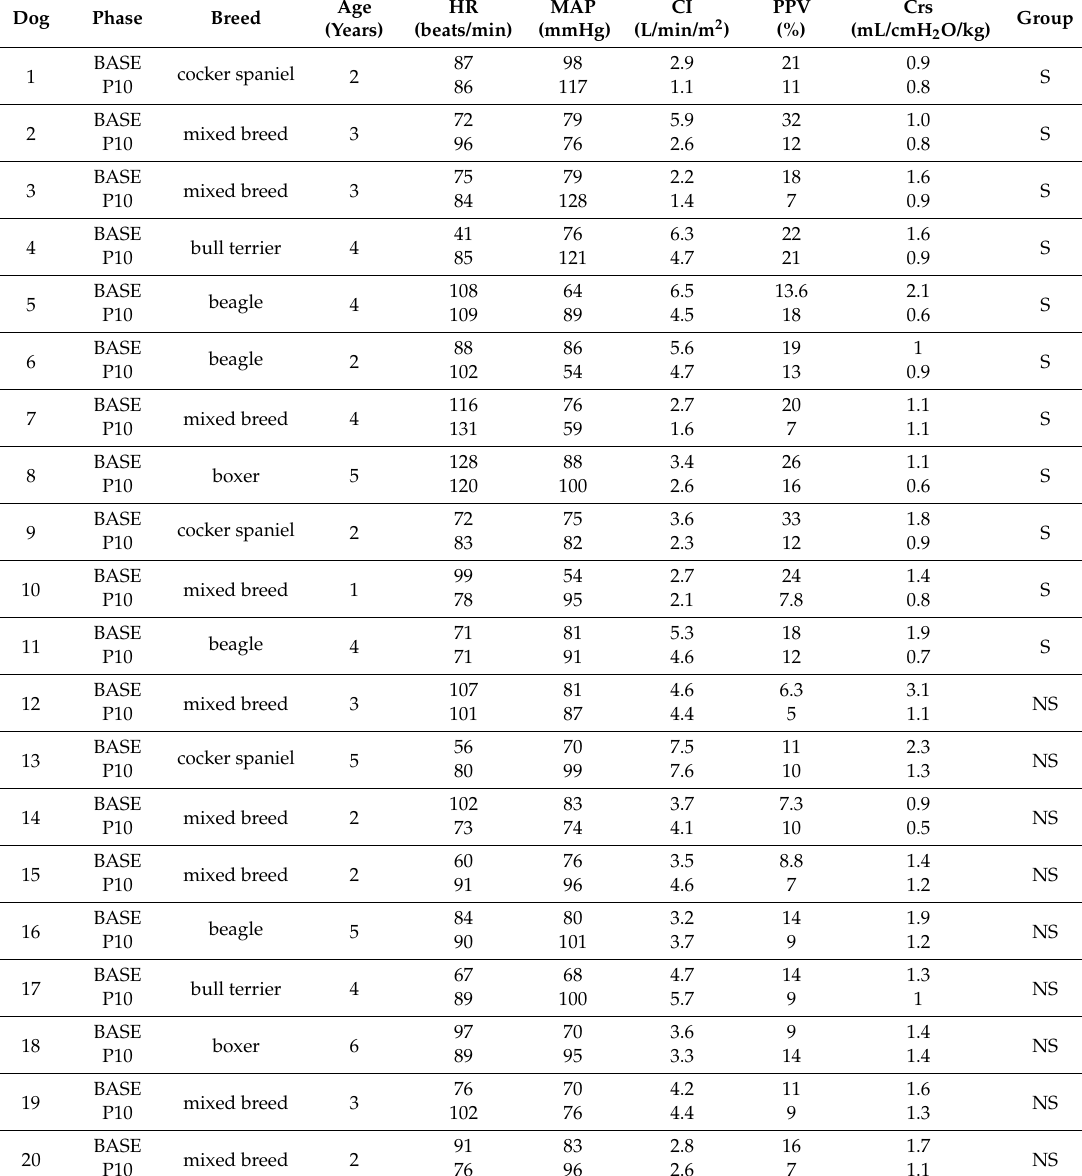
Table 1. Breed, age, heart rate (HR), mean arterial pressure (MAP), cardiac index (CI), pulse pressure variation (PPV), and respiratory system compliance (Crs) of the cases included in the study, immediately before (BASE) and 10 min after the pneumoperitoneum (P10). Dogs that showed a reduction of CI ≥ 15% at P10 compared to BASE were classified as sensitive (S), the rest of the dogs were classified as non-sensitive